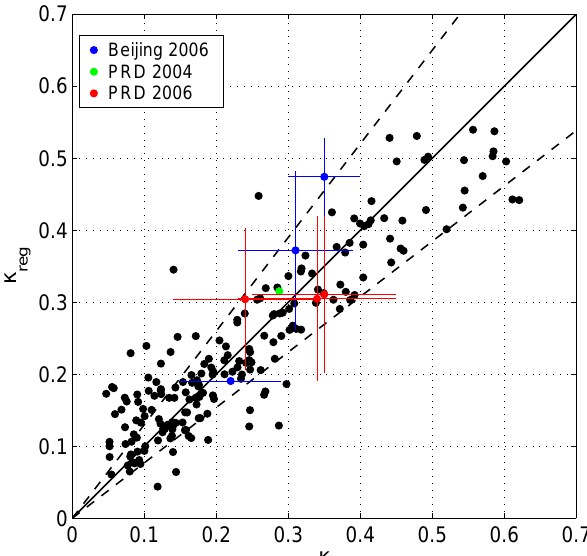
Fig. 9. The comparison of κ reg predicted from the parameteriza- tion scheme (ordinate) and κ derived from chemical composition (abscissa). Values of κ from former studies, predicted from the pa- rameterization scheme (ordinate) and derived from GF or CCN ac- tivation (abscissa), are displayed in colored points. Solid line is 1:1 line and dashed lines indicate 30% deviation from the 1:1